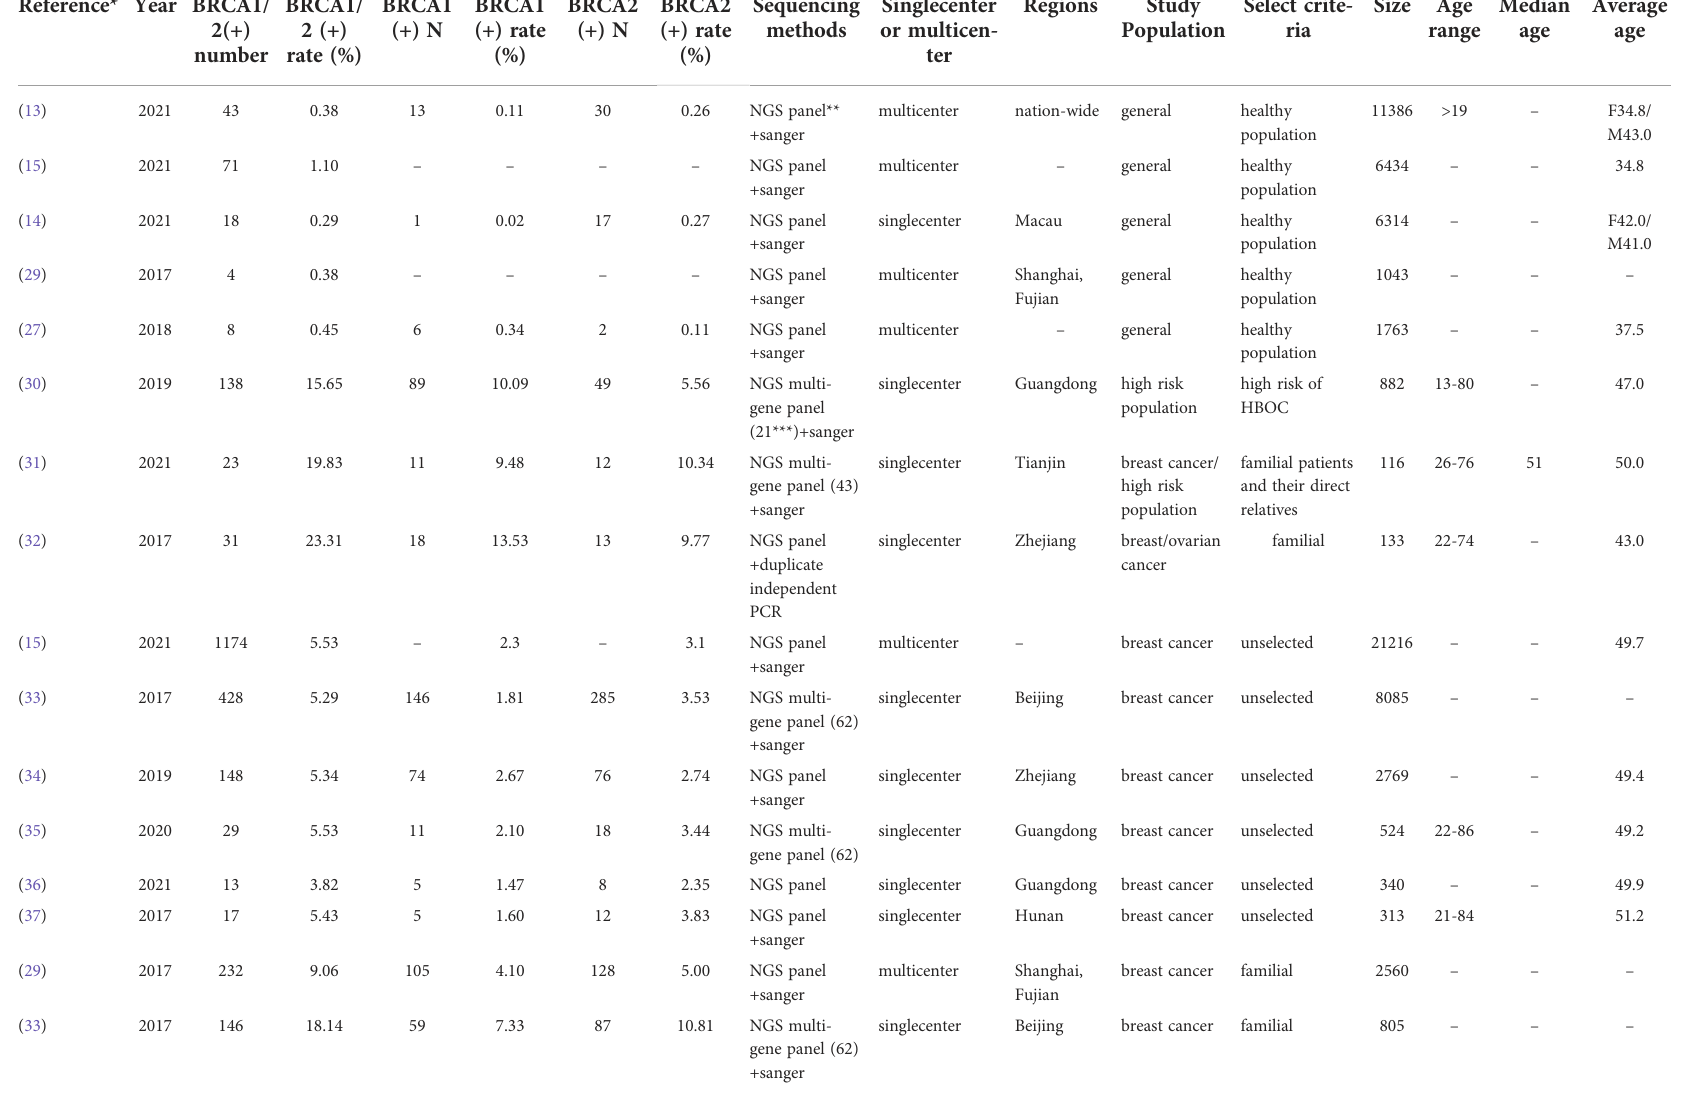
TABLE 1 Summary of BRCA prevalence studies from China in recent 5